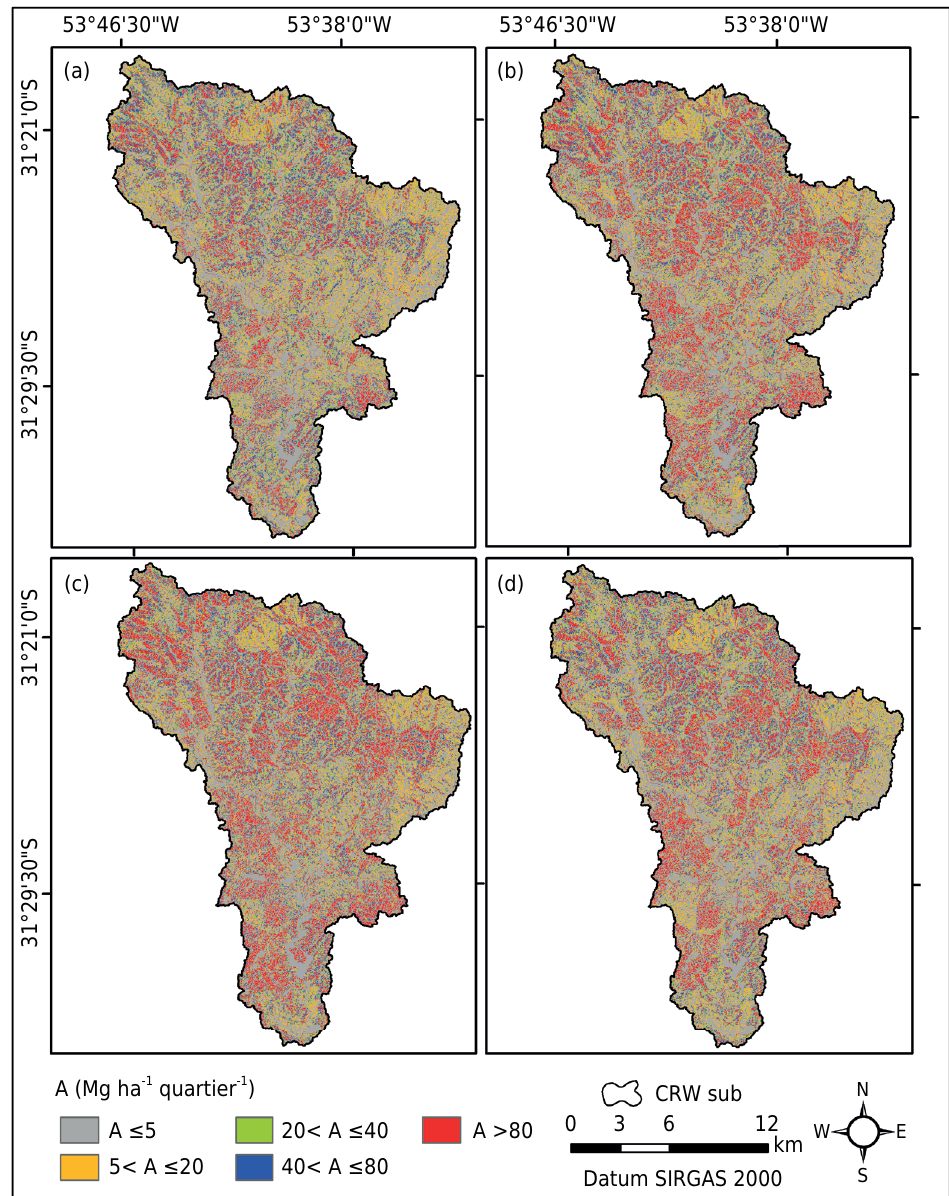
Figure 4. Soil loss (A – Mg ha -1 quartier -1 ) in (a) P1; (b) P2; (c) P3 and (d) P4 in the Candiota river watershed (CRWsub).